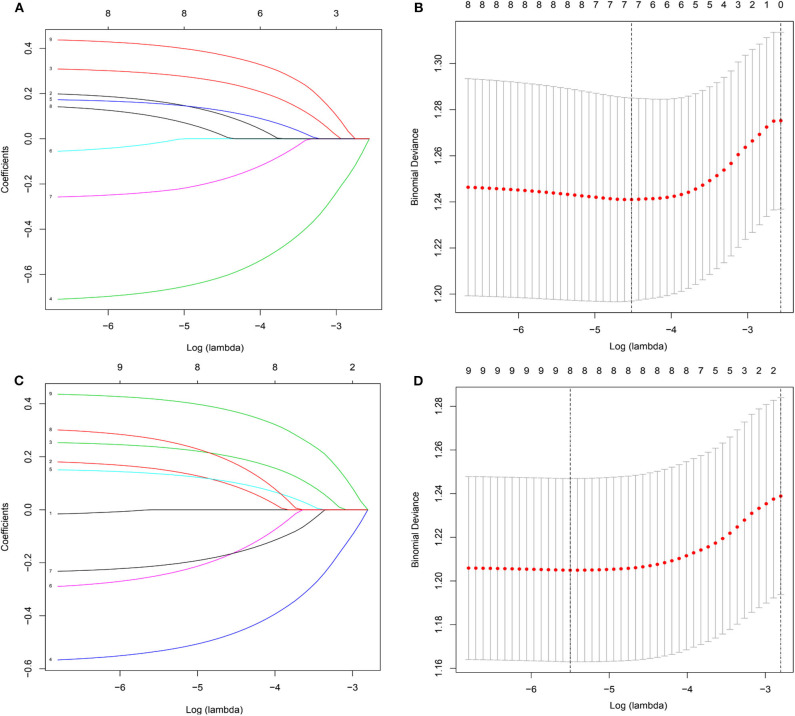
Demographic and clinical feature selection using the LASSO binary logistic regression model. (A,B) for overall survival; (C,D) for cancer-specific survival.